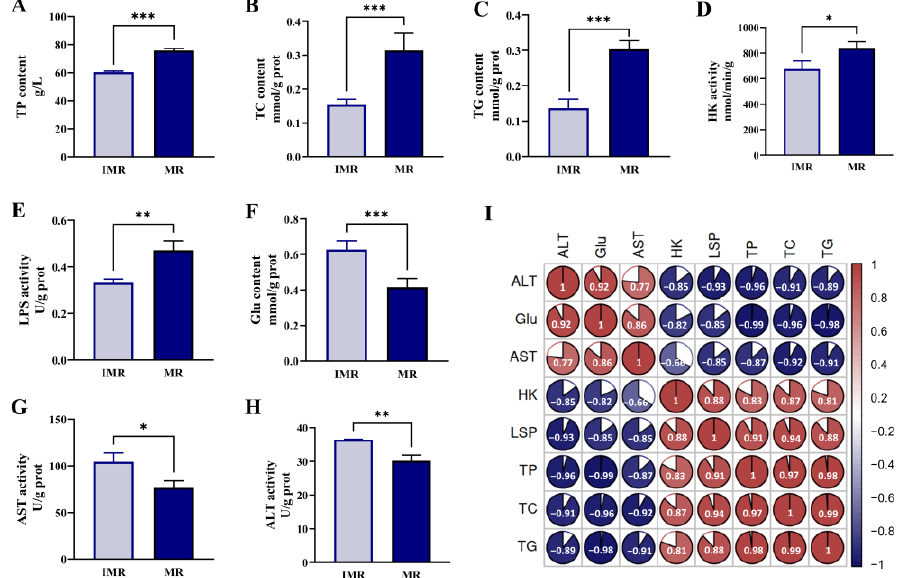
Figure 1. Changes in hepatic biochemical indicators between immature female rainbow trout and mature females. ( A ) total protein (TP), ( B ) total cholesterol (TC), ( C ) triglycerides (TG), ( D ) hexokinase (HK), ( E ) lipase (LPS), ( F ) glucose (Glu), ( G ) aspartate aminotransferase (AST), ( H ) alanine aminotransferase (ALT). IMR represents immature female rainbow trout; MR represents mature female rainbow trout. The data are presented as the means ± SD, and asterisks indicate statistically significant differences among the groups (* p < 0.05; ** p < 0.01; *** p < 0.001). ( I ) Pearson correlation analysis between the biochemical indicators, the size of the pie chart represents the magnitude of the correlation, red and blue represent positive and negative correlations,